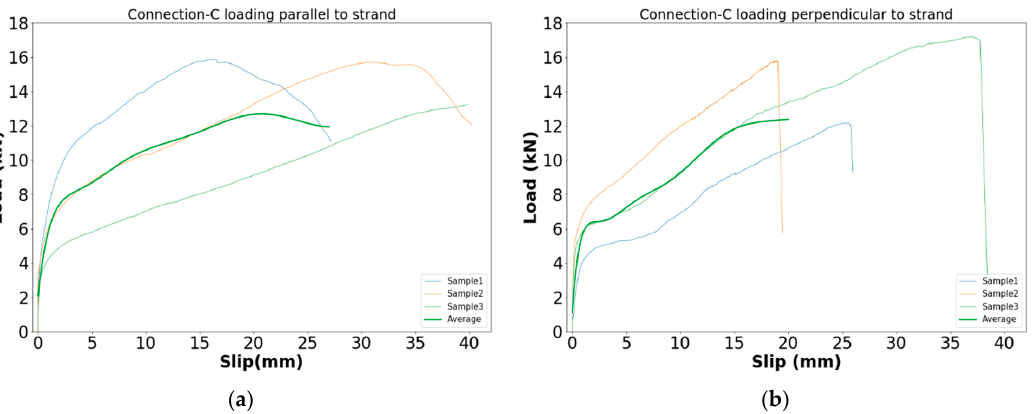
Figure 23. Load-slip curve of Connection-C: ( a ) loading perpendicular to the strand; ( b ) loading parallel to the strand.